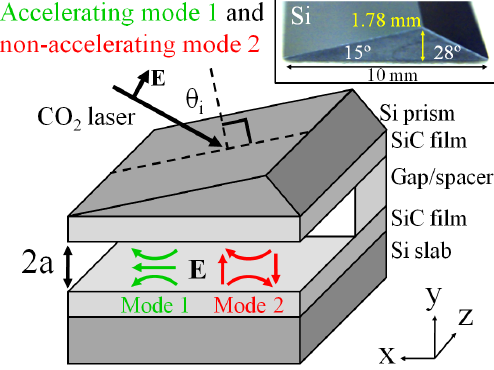
FIG. 2. Schematic of the SiC-based accelerator (not to scale). Thin layers of SiC are grown on Si slabs that can be fabricated into prisms. The prism couples p -polarized (TM) mid-IR radia- tion to the structure. A microfabricated spacer (one side shown) defines the vacuum gap for the beam accelerated by electric fields ( E , depicted by arrows) parallel to the SiC/vacuum interfaces. Inset: a photograph of the Si coupling prism. The fabricated sample has a 2 a ¼ 6 (cid:2) m gap, 1 : 7 - (cid:2) m -thick SiC films, 5-mm-thick Si slabs, and prism dimensions as defined in the